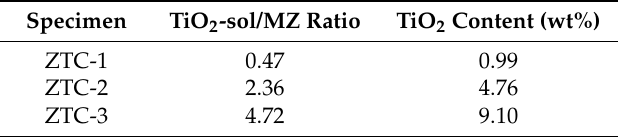
Table 3. The TiO 2 content of ZTC-1, ZTC-2, and